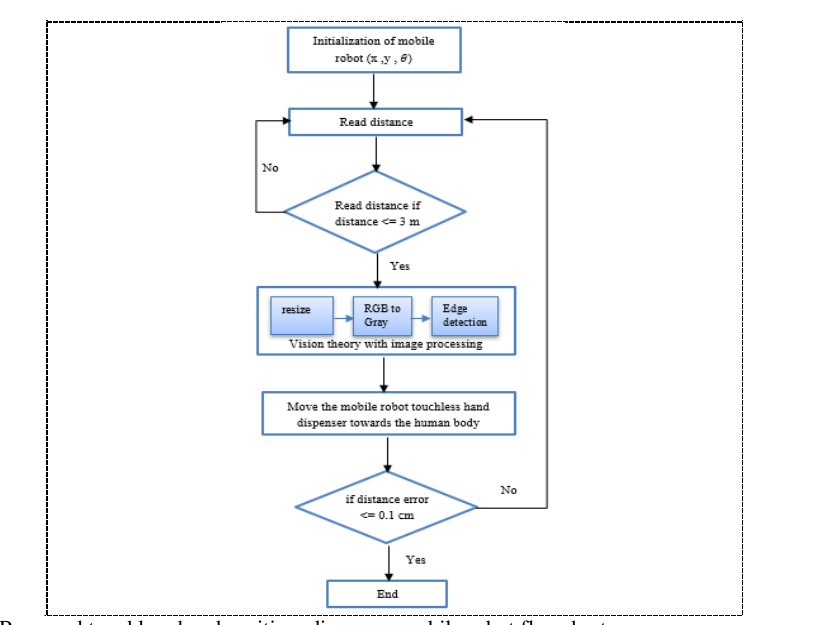
Fig. 2. Proposed touchless hand sanitizer dispenser mobile robot flowchart.